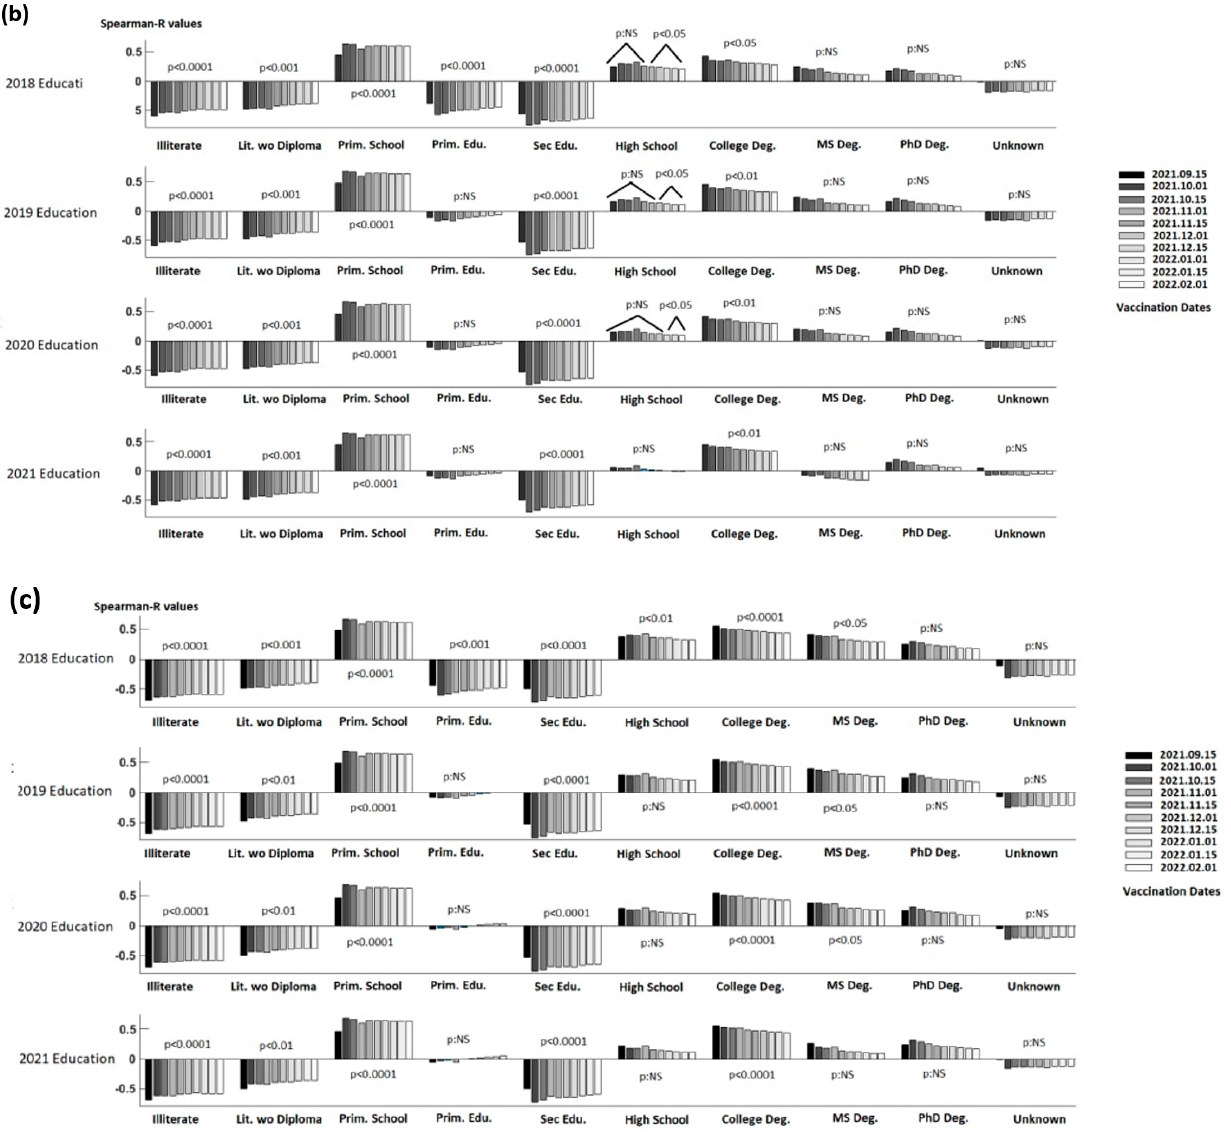
Figure 1. Spearman-R correlation coefficients (education percentage per city vs. double COVID-19 vaccination percentage in the city) for different educational levels (illiterate, literate without a diploma, primary school, primary education, secondary school/intermediate graduate, high school graduate, college degree, master’s degree, doctoral degree, and unknown) and years (2018–2021), between September 2021 and February 2022 COVID-19 vaccination measurement days (( a ) Total, ( b ) Male, ( c ) Female).